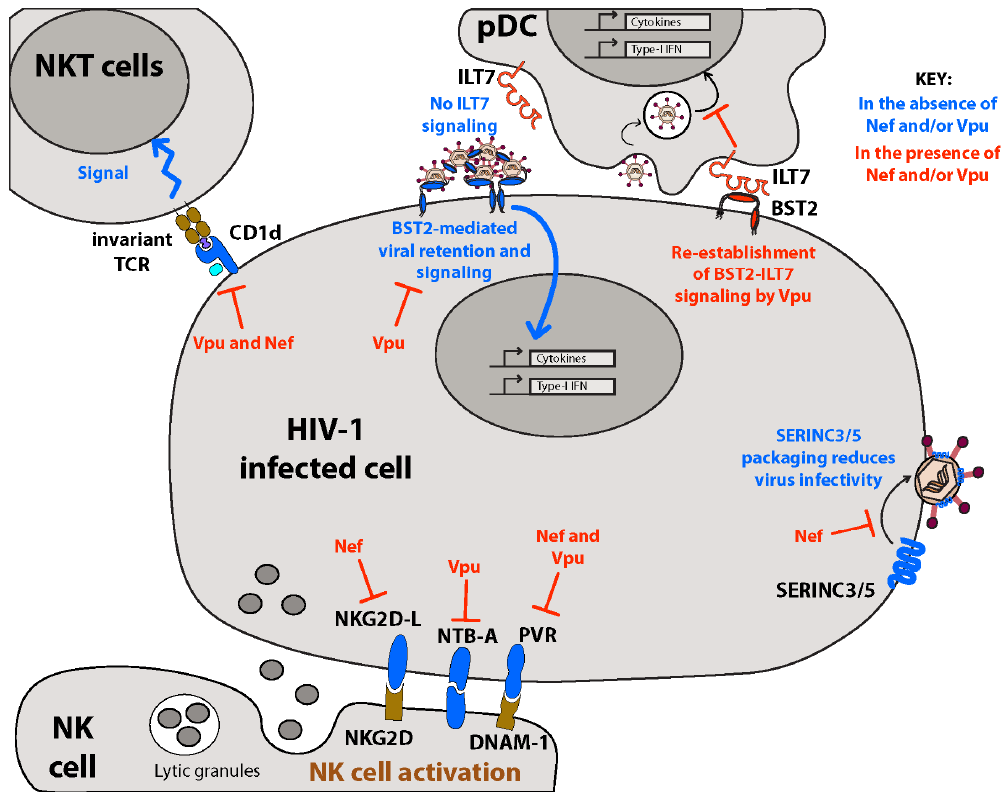
Figure 4. Remodeling of the plasma membrane by HIV ‐ 1 Nef and Vpu modulates intrinsic and innate immunity. HIV ‐ 1 Nef and Vpu proteins work in concert to alter the surface expression of host restriction factors (BST2 and SERINC3/5) and receptors/ligands important for innate immune responses. These processes promote viral immune evasion, allowing for dissemination and establishment of systemic spread during the acute phase of infection. Vpu ‐ mediated selective regulation of the BST2 long and short isoforms at the cell surface prevents virion tethering at the PM, allowing efficient particle release while reducing NF κ B activation in infected cells. Furthermore, differential targeting of the long and short isoforms of BST2 by Vpu allows the maintenance of a pool of surface BST2 that is free to engage and activate the plasmacytoid dendritic cells (pDC) ‐ specific ligand of immunoglobulin ‐ like transcript 7 (ILT7) inhibitory receptor, resulting in decreased type I interferon (IFN ‐ I) production. Nef ‐ mediated downregulation of serine incorporator (SERINC)3/5 decreases their packaging into virions and as such increases particle infectivity. Decreased surface expression of immunoreceptors such as natural ‐ killer group 2, member D ligands (NKG2D ‐ L), NK ‐ T ‐ B ‐ Antigen (NTB ‐ A), and polio virus receptor (PVR) by Nef and Vpu prevents clearance of infected cells by NK cells. Reduction of CD1d on infected DCs by Nef and Vpu prevents NKT cell activation and endorsement of immune responses.